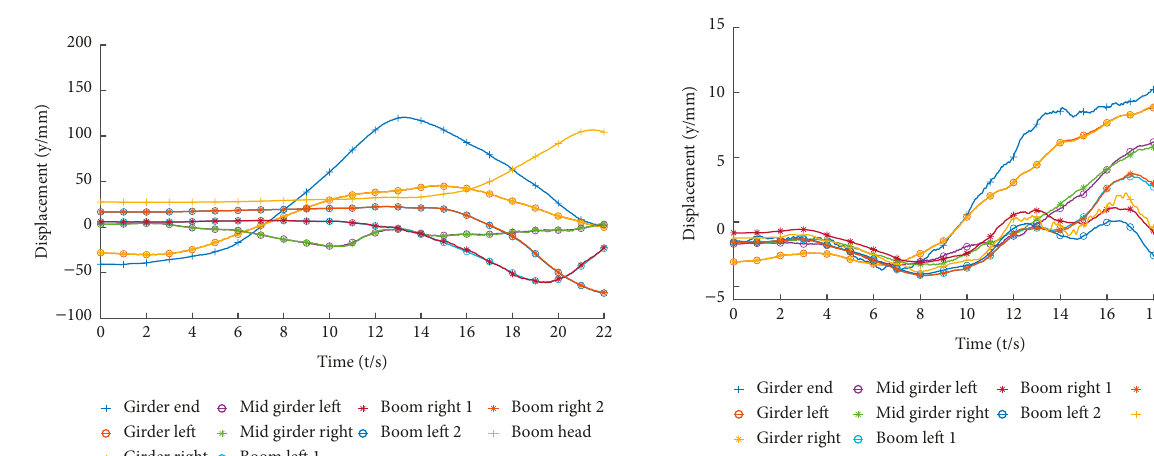
Figure 16: Time series of longitudinal displacement of girder at full length.